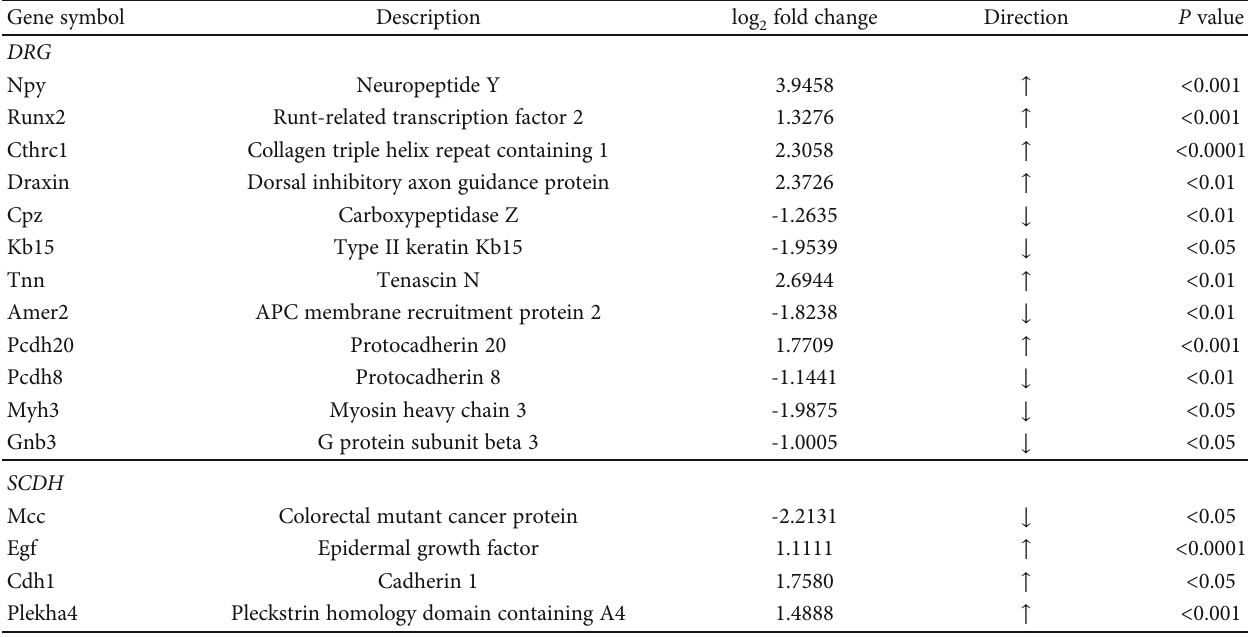
Table 1: DEGs related to Wnt pathway in DRG and SCDH of rats 28 days after